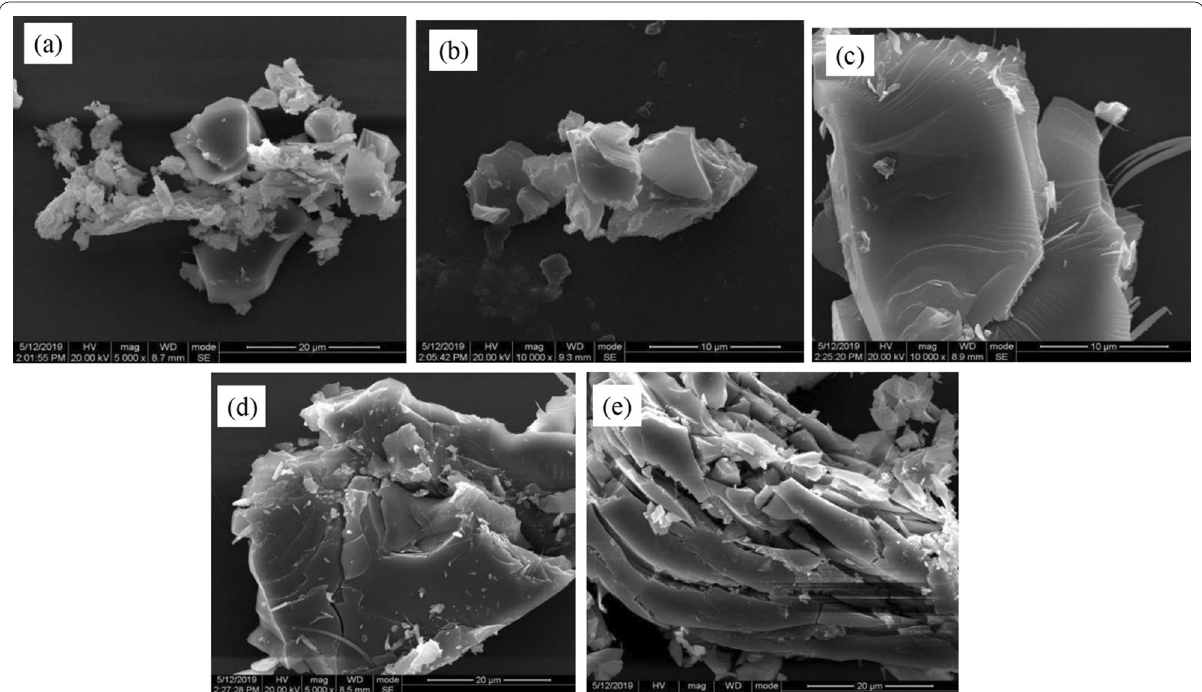
Fig. 4 SEM images of MoS 2 nanosheets under different sonication time. The sonication time are a 4 h, b 8 h, c 12 h, d 16 h, e 20 h,